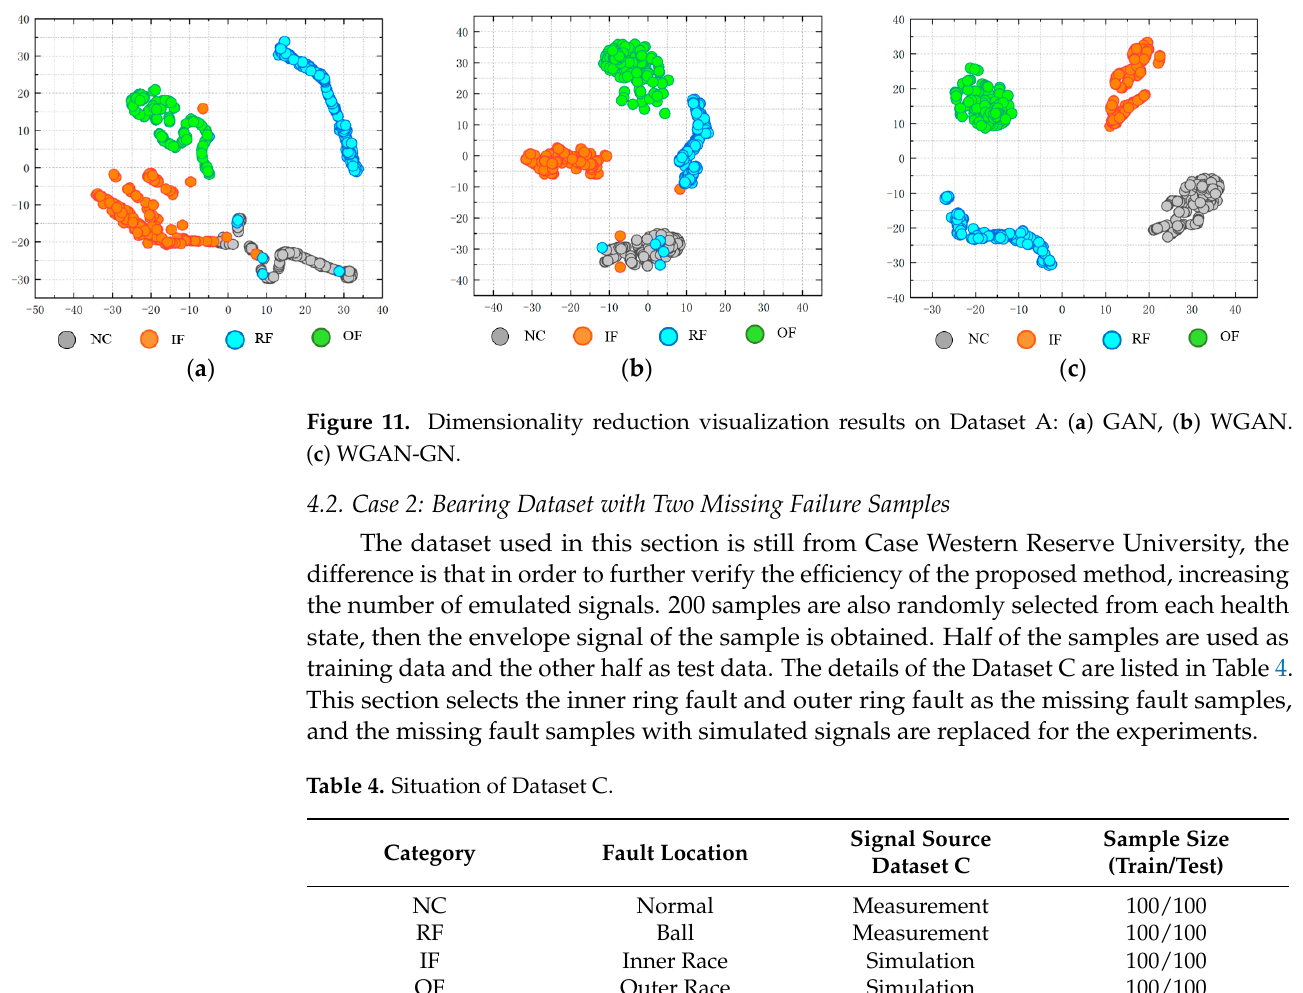
Figure 12. Dimensionality reduction visualization results on dataset B: ( a ) GAN. ( b ) WGAN. ( c ) WGAN-GN.